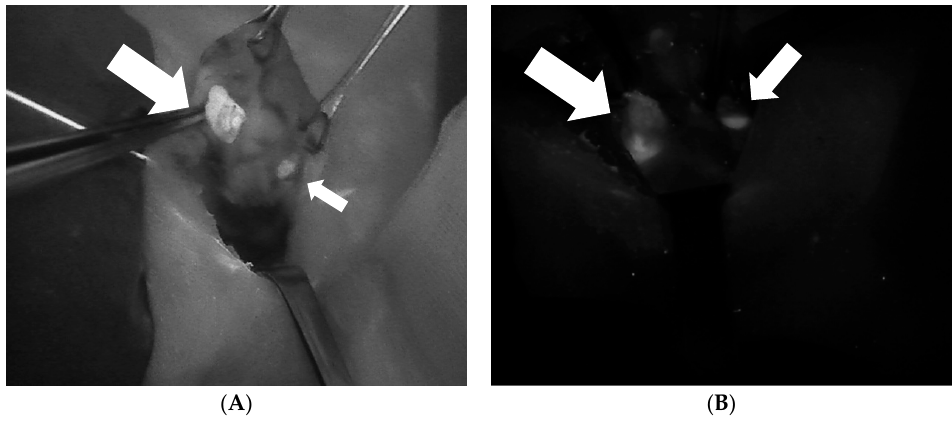
Figure 3. Two intraoperative images of parathyroid adenomas (larger arrow) demonstrating the heterogeneous fluorescence pattern that differentiates abnormal and normal parathyroid glands (smaller arrow). ( A ): Superior right parathyroid adenoma. ( B ): Inferior left parathyroid adenoma.